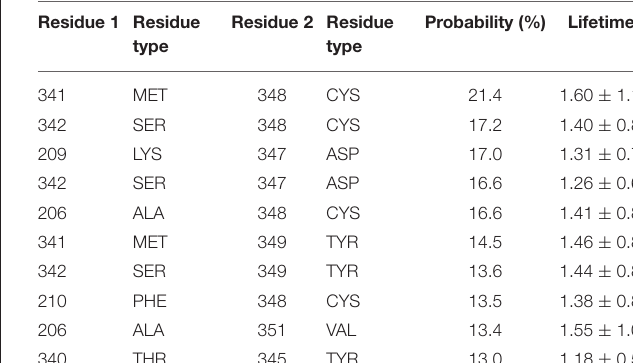
TABLE 3 | Interacting residue pairs between C-terminus and BAR